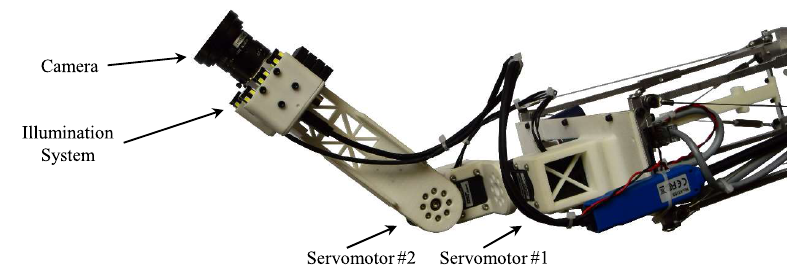
Figure 9. Pan and tilt mechanism together with the camera.